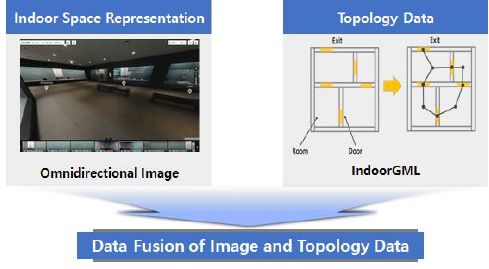
Figure 3. Data Requirements for Data Fusion